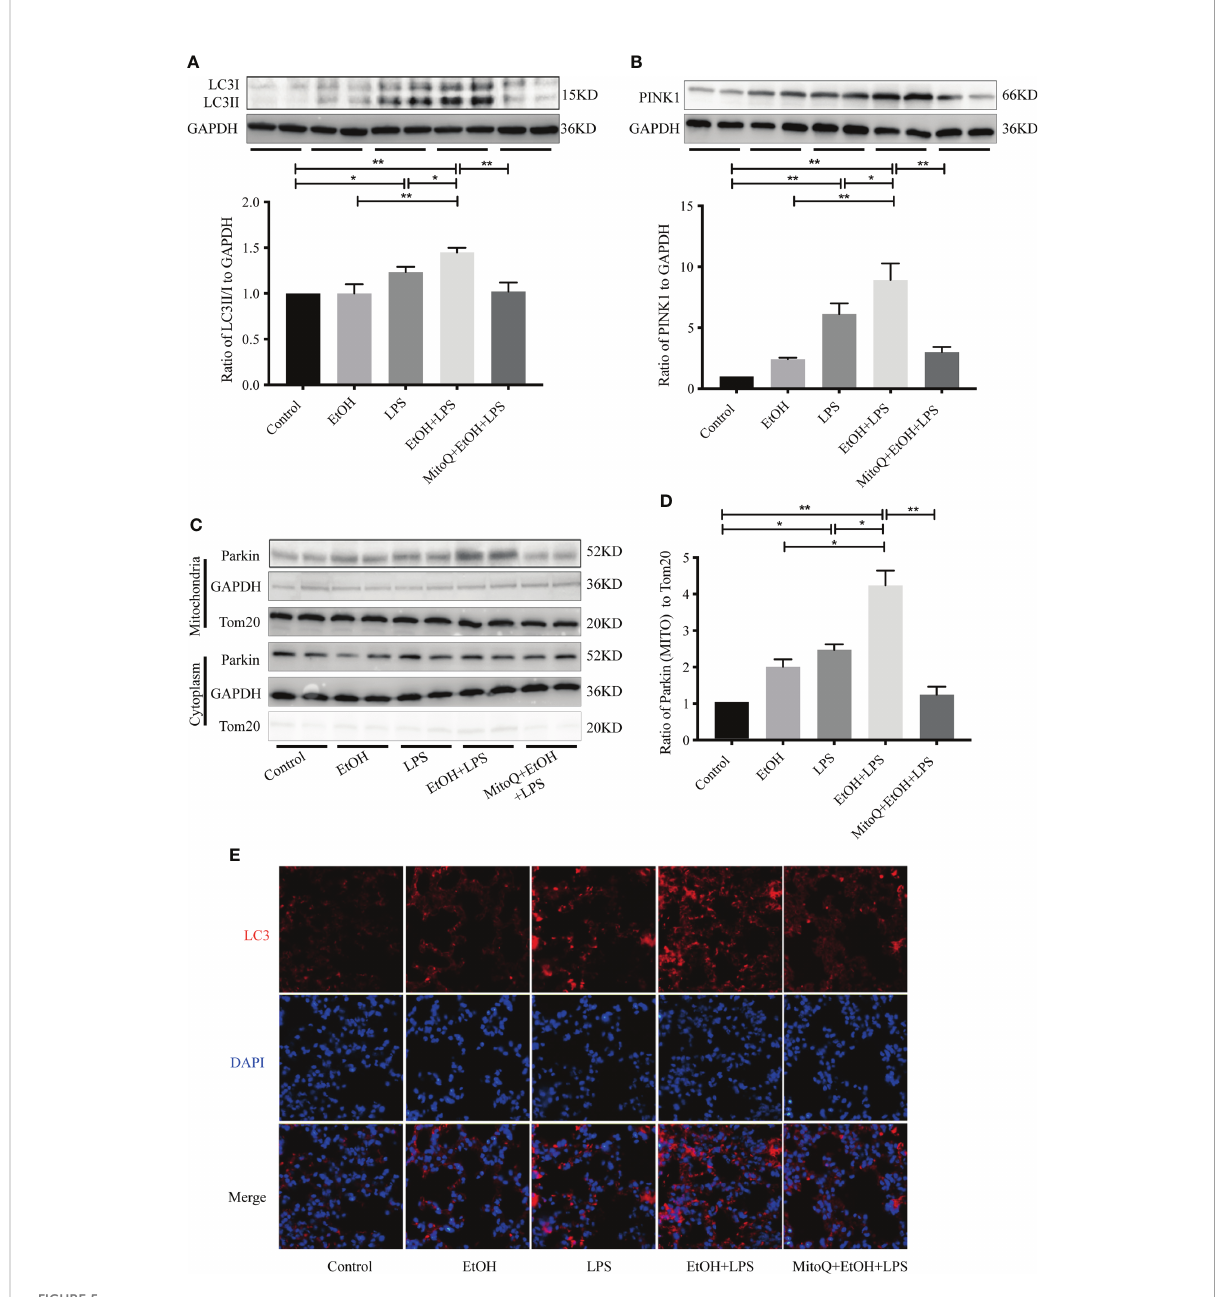
FIGURE 5 MitoQ inhibited ethanol-LPS-induced mitophagy activation. (A) Representative western blot images indicated LC3 protein expression. (B) Representative western blot images indicated PINK1 protein expression. (C) Expression of Parkin protein in cytoplasm and mitochondria were detected by western blotting. (D) Relative expression of the protein was normalized against GAPDH. (E) Representative immunohistochemistry images of LC3. All images are shown at identical magni fi cation (×400). All data were presented as mean ± SEM (n=6 in each group), *P < 0.05, **P <